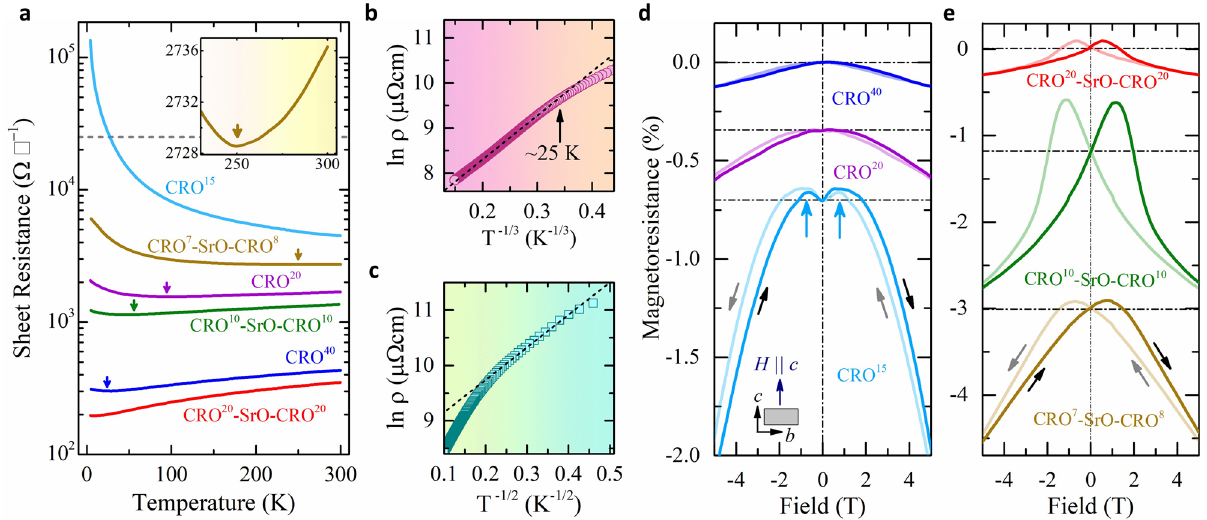
Fig. 3 Electron transport of pristine and δ -doped CRO fi lms. a Temperature-dependent sheet resistance. In panel a the dashed gray-line marks the Mott – Ioffe – Regel limit representing quantum of resistance ( h / e 2 ≈ 25 k Ω / □ ), while the arrows indicate the characteristic temperature below which a resistivity upturn occurs. The inset of a shows the temperature-dependent sheet resistance of CRO 7 -SrO-CRO 8 , highlighting the resistivity upturn. Logarithmic plots of CRO 15 resistivity as a function of b T − 1/3 (Mott VRH), and c T − 1/2 (Efros VRH). d , e Magnetoresistance (MR) at T = 5 K with the magnetic fi eld applied along the fi lm normal. The MR curves in d , e are offset to prevent overlapping.